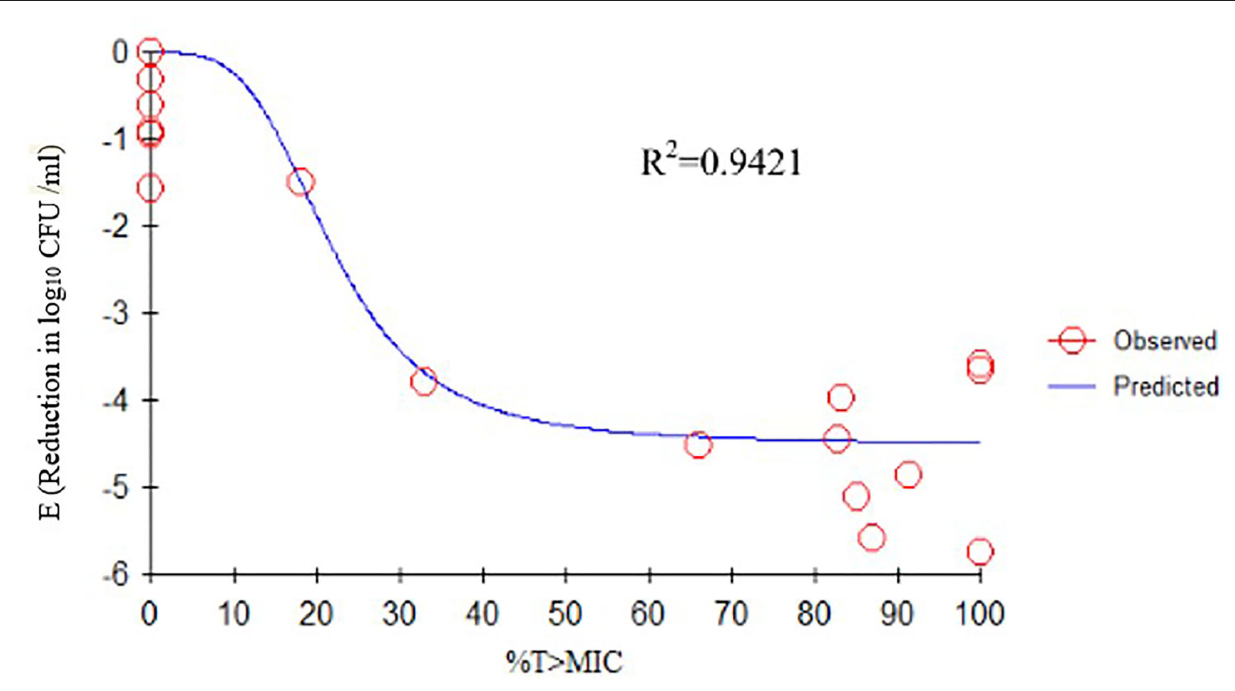
FIGURE 3 | E max relationships between PK/PD parameters (%T > MIC) and antibacterial activity. R 2 is the correlation coefficient. PK/PD, pharmacokinetic/pharmacodynamic; MIC, minimum inhibitory concentration. 2 × MIC and greater within 6 h ( Figure 1 ). Additionally, after a pleuropneumoniae both in vitro and in vivo . In vitro time-killing single IM dose of 5 mg/kg, a 5 – log 10 CFU/ml reduction could curves demonstrated that a reduction in A. pleuropneumoniae be observed within 9 h, and no bacteria were detected after 12 counts to the detection limit was achieved at concentrations of